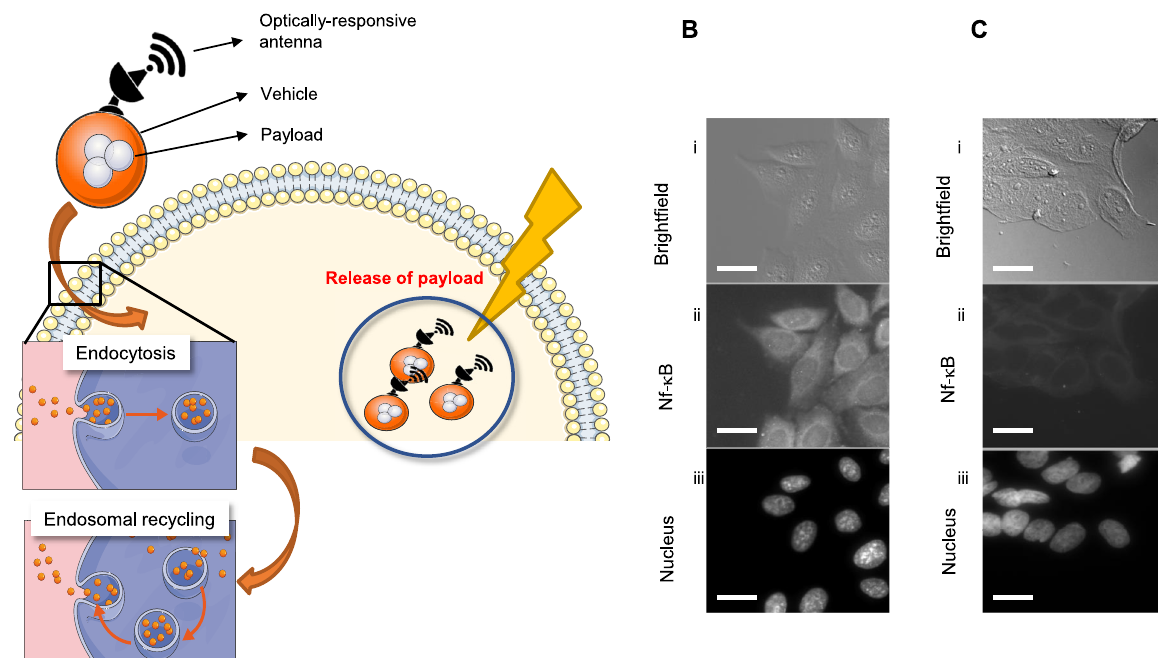
Figure 4: Photoactivated plasmonic nanoparticles as proof of concept on-demand release of payloads in tumor cells. (A) Schematic shows plasmonic nanoparticles as optical antennas and carriers of drug payloads that release under NIR. Inset shows hypothetical endosomal internalization of nanoparticles. (B and C) Representative images show NF-kB expression in HeLa cells treated with gold nanocarriers containing a control (scrambled) siRNA vector (b) or siRNA targeting the NF-kB gene (c) Panels show (i) DIC, (ii) anti NF-kB AF488 immuno fl uorescence, and (iii) DAPI. Scale bar = 10 μ